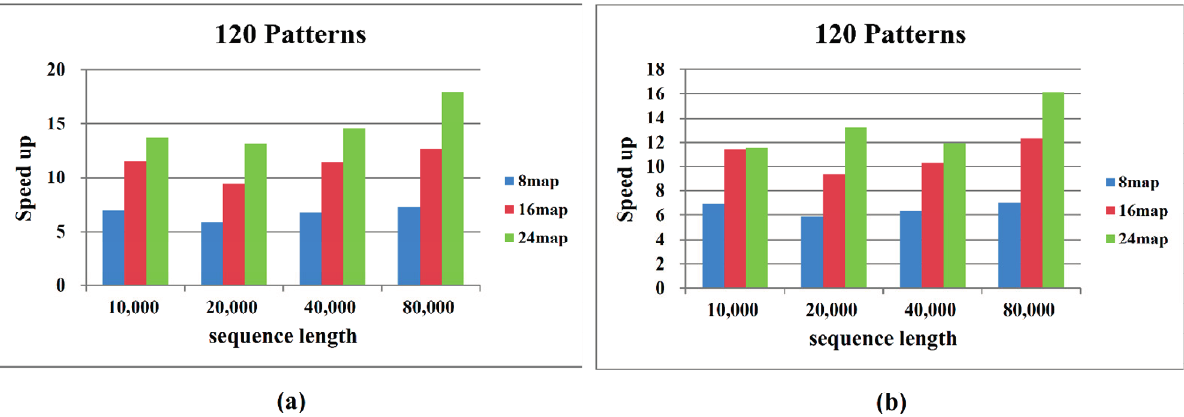
Figure 6. Speed-up comparison between sequential and MapReduce haplotype block selection: ( a ) block size of 300 bp and ( b ) block size of 500